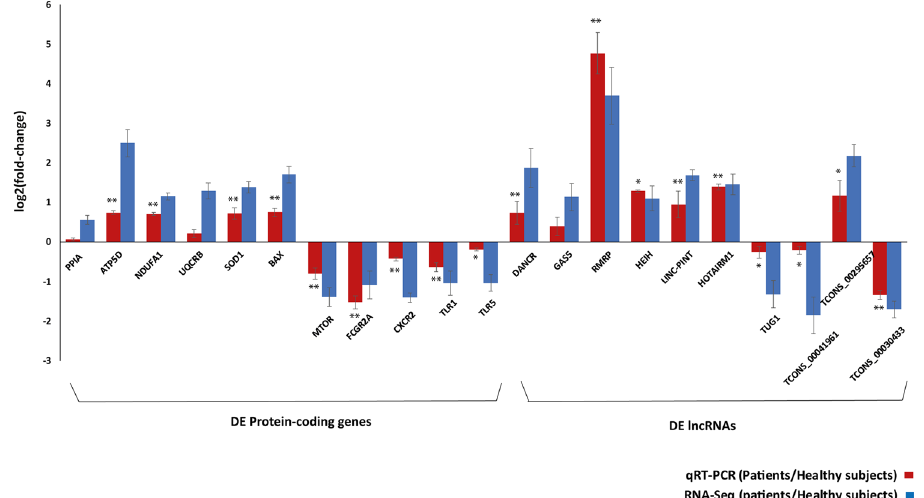
Figure 6. The qRT-PCR validation of DE protein-coding genes and DE lncRNAs in primary monocytes of XLA patients compared to the healthy subjects. The comparison of log 2 fold-change of DE protein-coding genes and DE lncRNAs were determined by RNA-Seq analysis (blue) and qRT-PCR validation (red). PPIA was used as endogenous control for normalizing the expression levels. x-axis shows genes; y-axis shows the log 2 ratio of expression in XLA patients compared to healthy subjects. Statistical significance was calculated using paired Student’s T-test. The asterisks above the bars denote statistically significant differences from healthy subjects obtained by qRT-PCR, * P-value < 0.05, ** P-value <